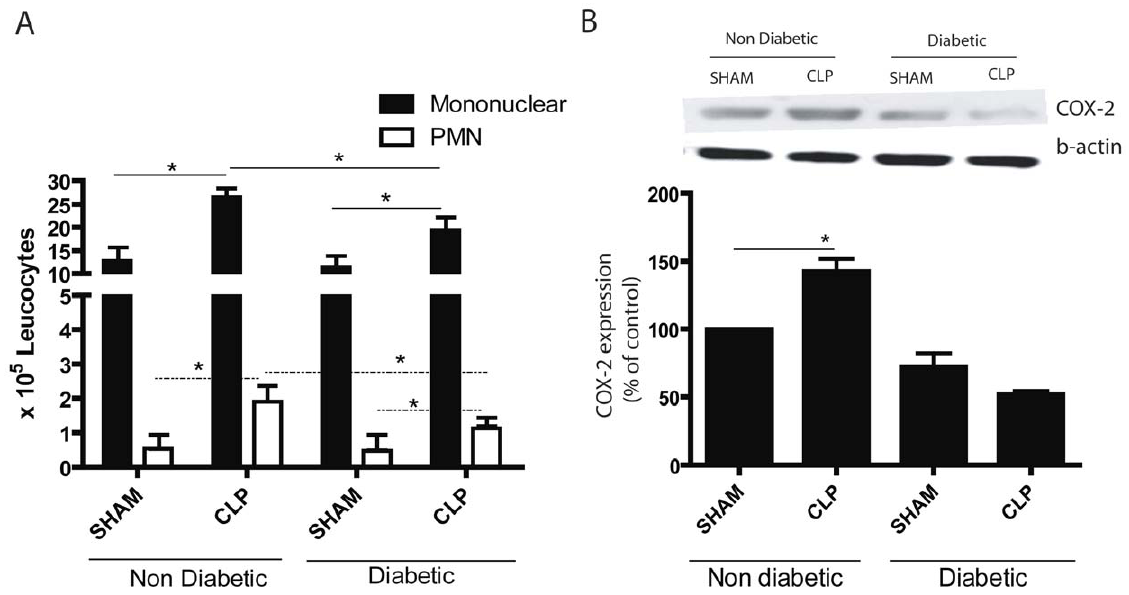
Figure 4. Inflammatory cell infiltration in BAL fluid and lung COX2 expression at 6h after CLP. Diabetic and non-diabetic rats were submitted to CLP or SHAM (false surgery) and after 6h bronchoalveolar lavage (BALF) was performed. ( A ) mononuclear and PMN cell were counted in haematoxilin-eosin stained cytospin preparations of BALF cells after total cell count was performed under light microscopy. ( B ) Expression of COX2 protein in lung homogenates six hours after CLP analysed by immunoblotting using antibodies to COX-2 and quantified by densitometric analysis of the immunoblot bands. Density values of bands were normalized to the total b -actin present in each lane and expressed as a percentage of control. n=5/group, data are presented as mean 6 SEM; *, P ,